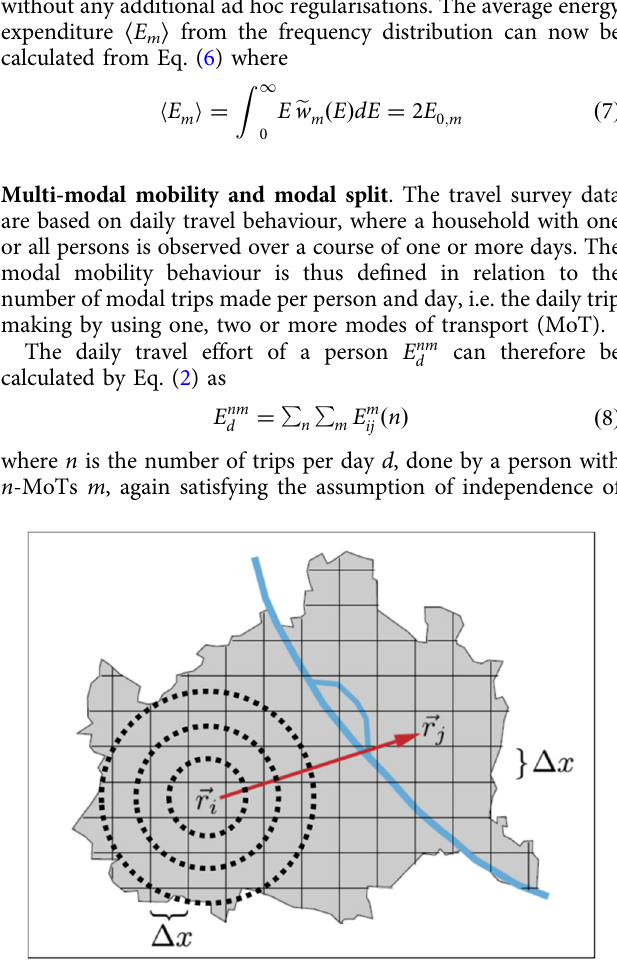
! ! and destination r j with a